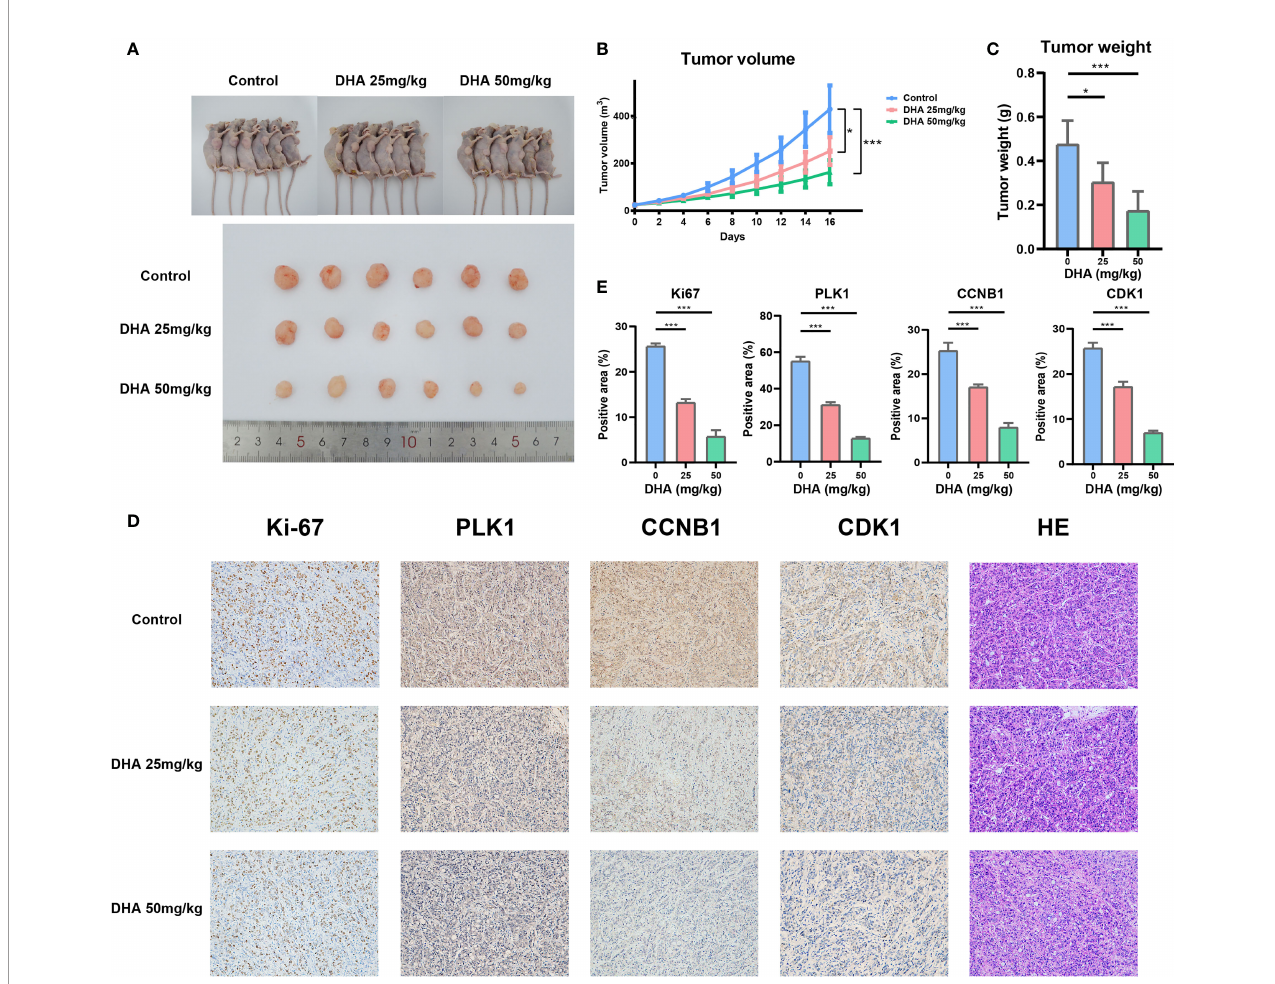
FIGURE 6 | DHA suppressed the in vivo tumorigenesis of CRC. (A) Representative images of xenograft tumors are shown. (B, C) The growth curves of tumor volumes were plotted, and the tumor weight of each mouse was measured. (D, E) Representative images of IHC images of Ki-67, CDK1, CCNB1, and PLK1 and H&E staining in control and DHA treatment groups. Data are shown as means ± SD. *p < 0.05, ***p < 0.001. DHA, dihydroartemisinin; CRC, colorectal cancer; IHC,